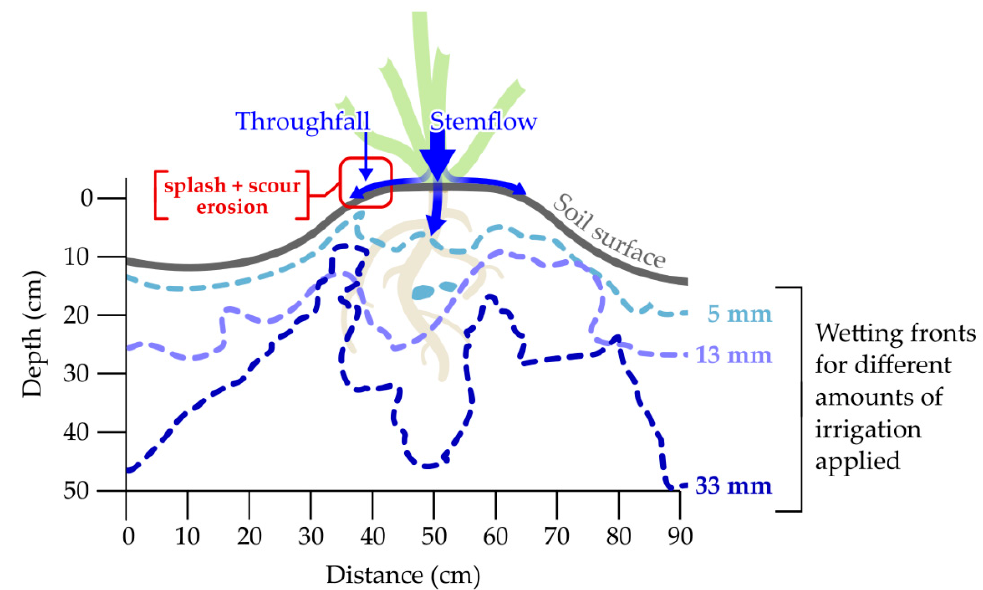
Figure 4. Digitized wetting fronts in a Plainfield loamy sand soil (Typic Udipsamment; sandy, mixed, mesic) observed beneath a potato crop ( Solarium tuberosum L, var. Russet Burbank) with increasing sprinkler-irrigation amounts (adapted from [26]). A preferential infiltration feature visibly forms with increasing irrigation beneath the stem base, likely due to stemflow infiltration along roots. Note that a portion of stemflow can become surface run-off and potentially enhance throughfall droplet-related erosional processes (through creation of rapid lateral jets from splash-on-film [72] or by transporting impact-related particles [59]).